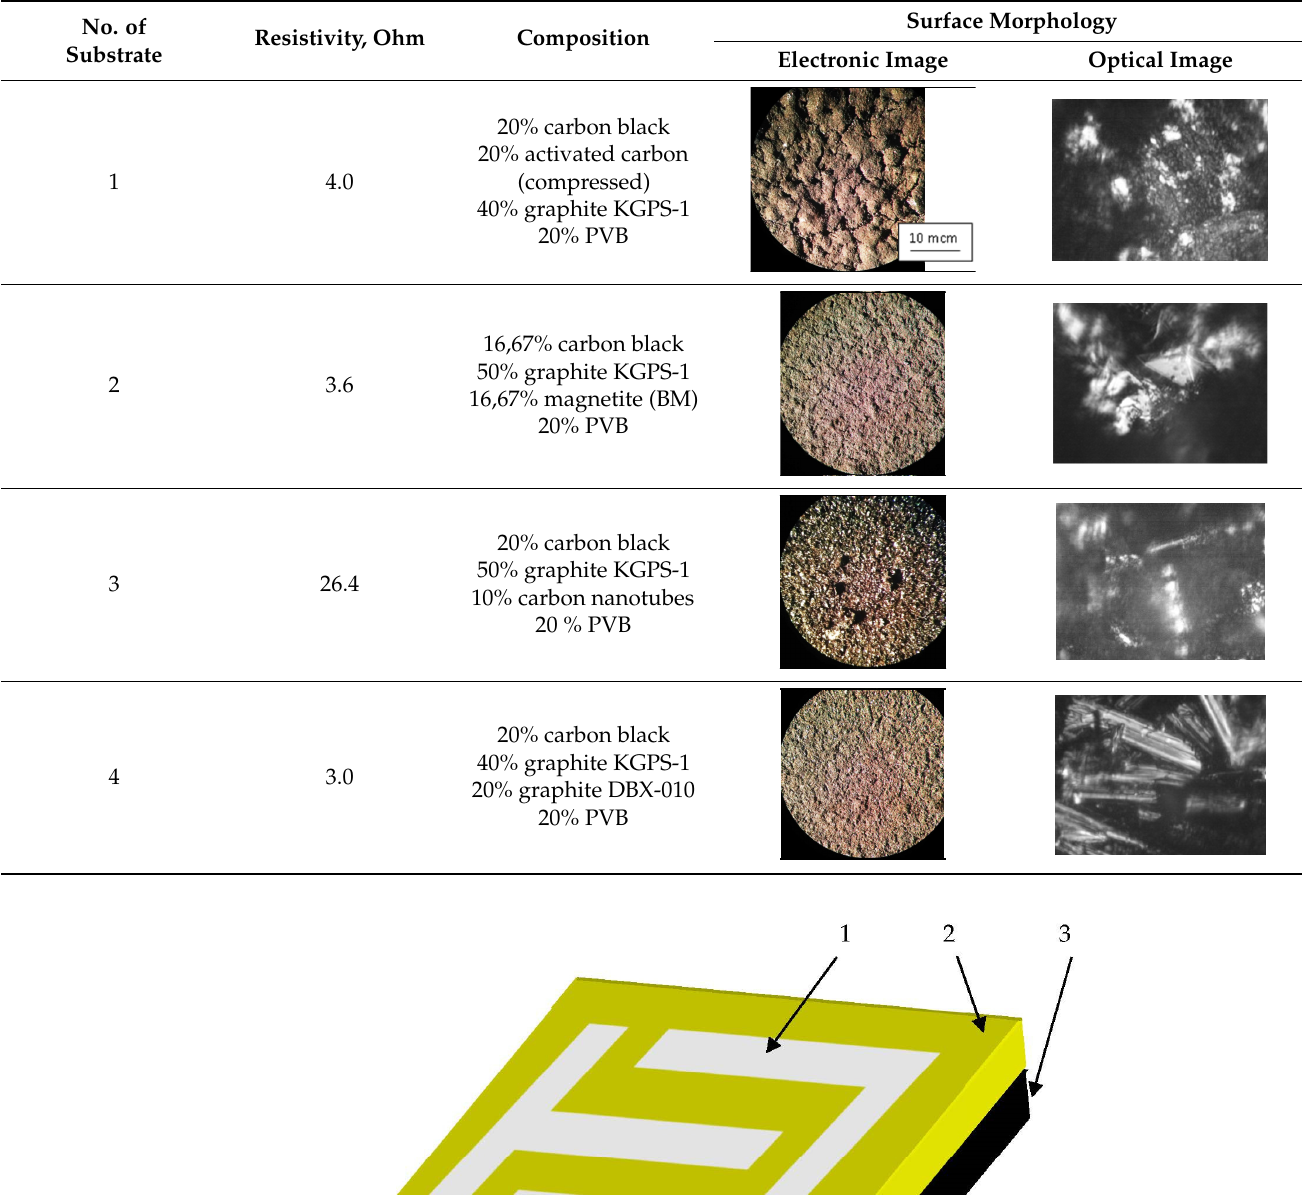
Table 2. Conditions for the formation of carbon substrates and their SEM and optical images.